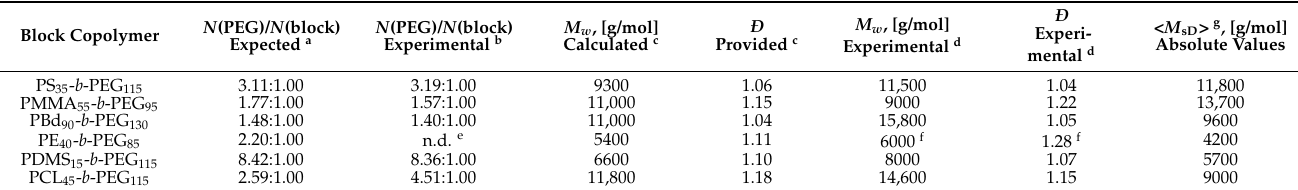
Table 1. Block copolymer characterization by 1 H NMR (DMSO- d 6 ), GPC (THF, 40 ◦ C) and AUC/DLS (THF, 20 ◦